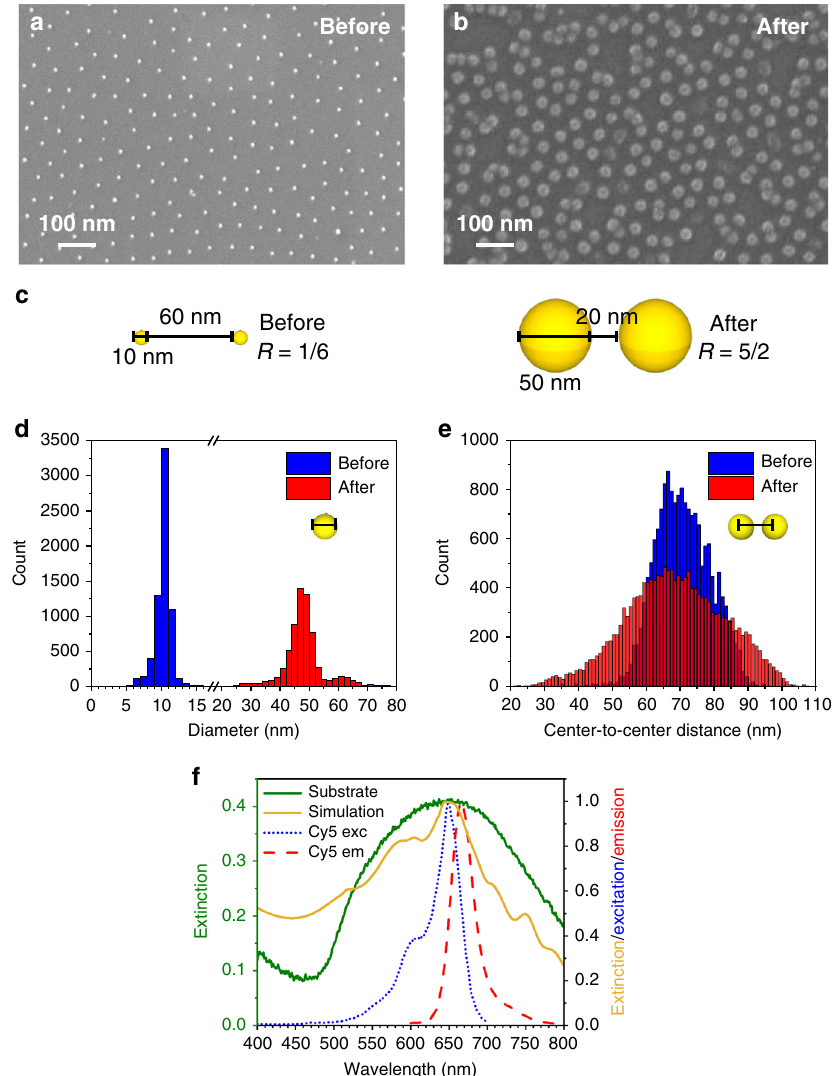
Fig. 3 Substrate characterization. a , b Top view SEM images of the AuNP array show high regularity of nanoparticle shape and size. Defects arising during the AuNP growth step, such as clusters and holes are randomly distributed on the substrate. c Sketch of the AuNP growth process. The nanoparticle diameter increases approximately fi ve-fold while the interparticle distance reduces three-fold by holding the lattice period (center-to-center distance among nearest neighbors) equal to ~70 nm. The R value goes from ~0.17 to ~2.5 warranting a collective plasmonic behavior of the AuNPs immobilized on the substrate. d Histograms of nanoparticle diameter before (blue columns) and after (red columns) incubation with gold growth solution. The distributions are peaked at ~11 nm and ~48 nm, respectively. e Center-to-center distance histograms exhibit similar distributions con fi rming the holding of most of AuNP positions also after the gold growth process. The wider distribution delivered by the substrates after the AuNP growth (red columns) is due to the presence of lattice irregularities and defects arising during the incubation process. f The experimental extinction spectrum of the substrate (green continuous line) is well reproduced by simulating the optical response provided by the actual substrate morphology as measured by SEM (gold continuous line). The excitation and emission peaks of Cy5 (dotted blue line and dashed red line, respectively) are encompassed within the substrate plasmon